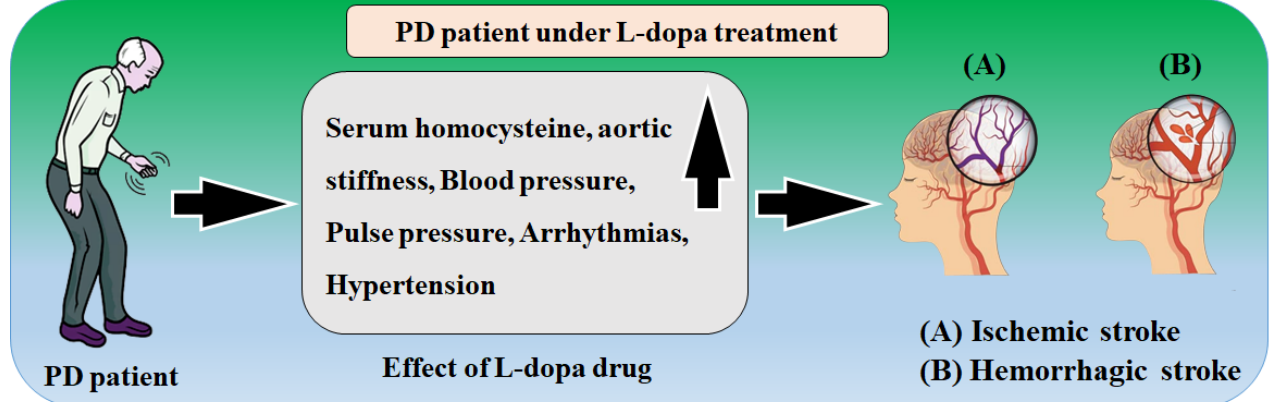
Figure 5. The relationship between L-dopa and stroke.